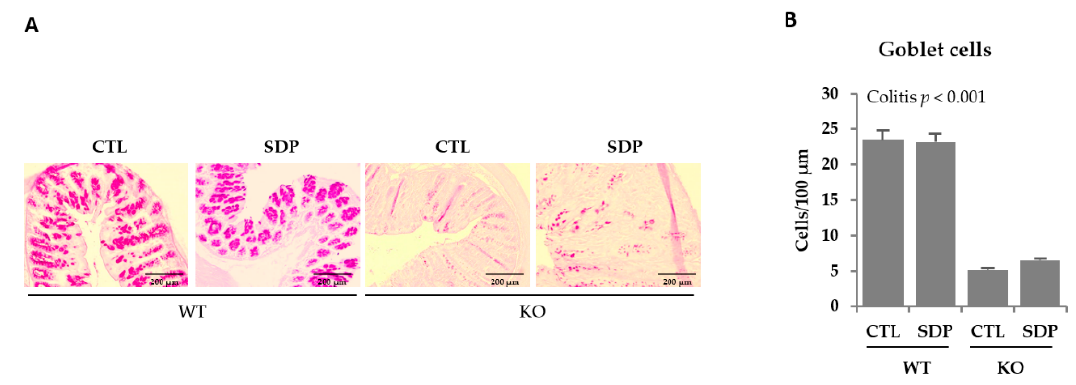
Figure 3. Effects of SDP supplementation on the levels of goblet cells in the colonic mucosa of Mdr1a KO mice. ( A ) Representative images periodic acid-Schiff staining of goblet cells in colon tissue. Images were taken at ×10 magnification. ( B ) Quantification of goblet cells in the colonic mucosa. Results are expressed as mean ± SEM ( n = 5–7 mice/group).